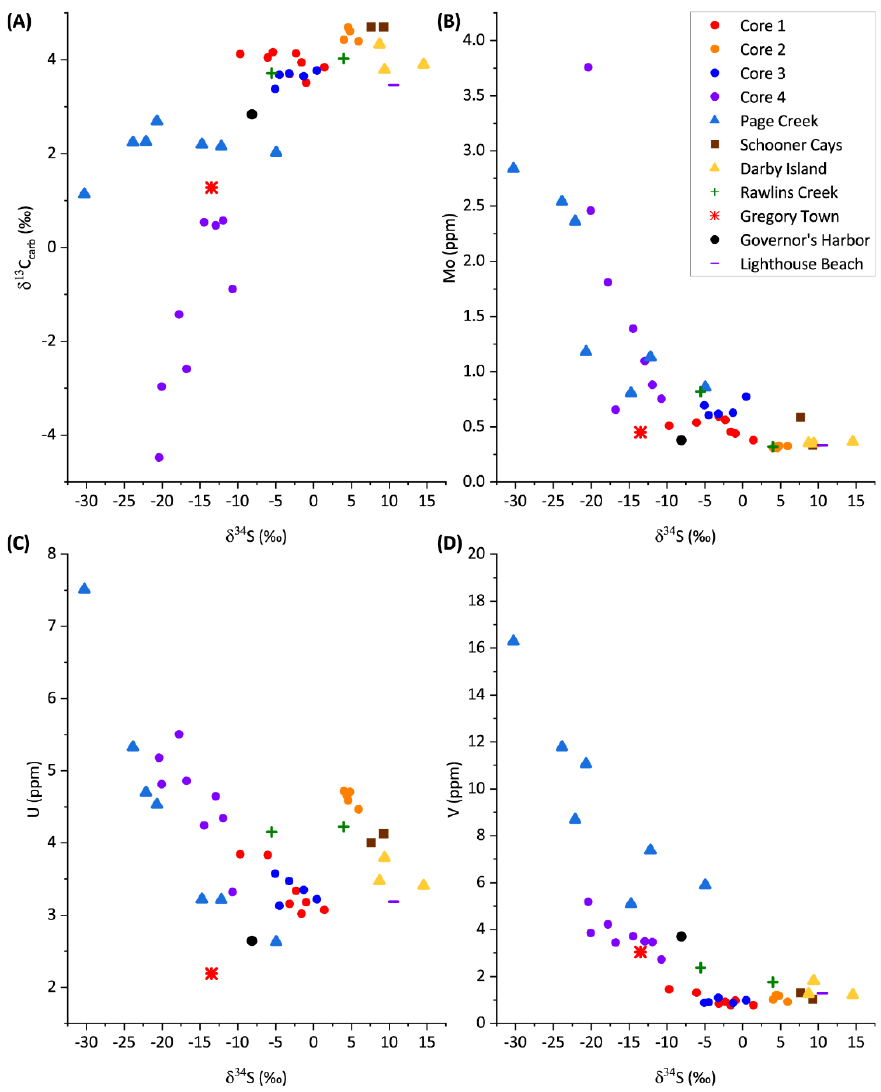
Figure 7. Trace metal and stable isotope geochemistry of bulk sediment samples. The accumulation of U downcore in cores 1 and 3 in the exchangeable phases, along with reducing pore water conditions conducive to precipitation of mononuclear U(IV), suggests an authigenic accumulation of mononuclear U(IV). The remaining chemical phases sum to a concentration of U between ~3 and 5 ppm, similar to primary precipitates [8], indicating authigenically accumulated U is quantitatively removed in the first sequen ‐ tial extraction phase. Reduction of U(VI) to U(IV) provides the largest known natural fractionation of 238 U/ 235 U, making it a potentially valuable proxy for ocean redox conditions [5,6,8]. Due to the long ocean residence time of U (~350 ka) compared to ocean mixing timescales (~1.5 ka), the composition of open seawater should theoretically reflect the globally uniform 238 U/ 235 U values of a given time and give a global view of redox conditions [47]. While primary precipitates incorporate the 238 U/ 235 U values of seawater, early diagenesis imparts an authigenic signature creating a bulk heavier 238 U/ 235 U value of 0.2–0.4‰ with depth and suggests an authigenic accumulation of isotopically heavy U downcore [10]. Until re ‐ cently, authigenic accumulations of U were generally thought to be the product of micro ‐ bial or chemical reduction and take the form of uraninite, though uraninite is rarely found